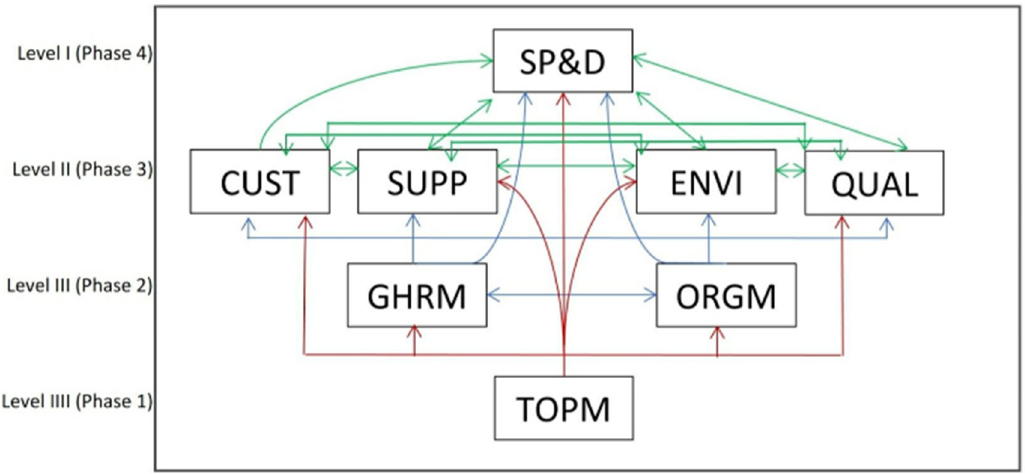
Figure 7. Final diagraph of ISM.